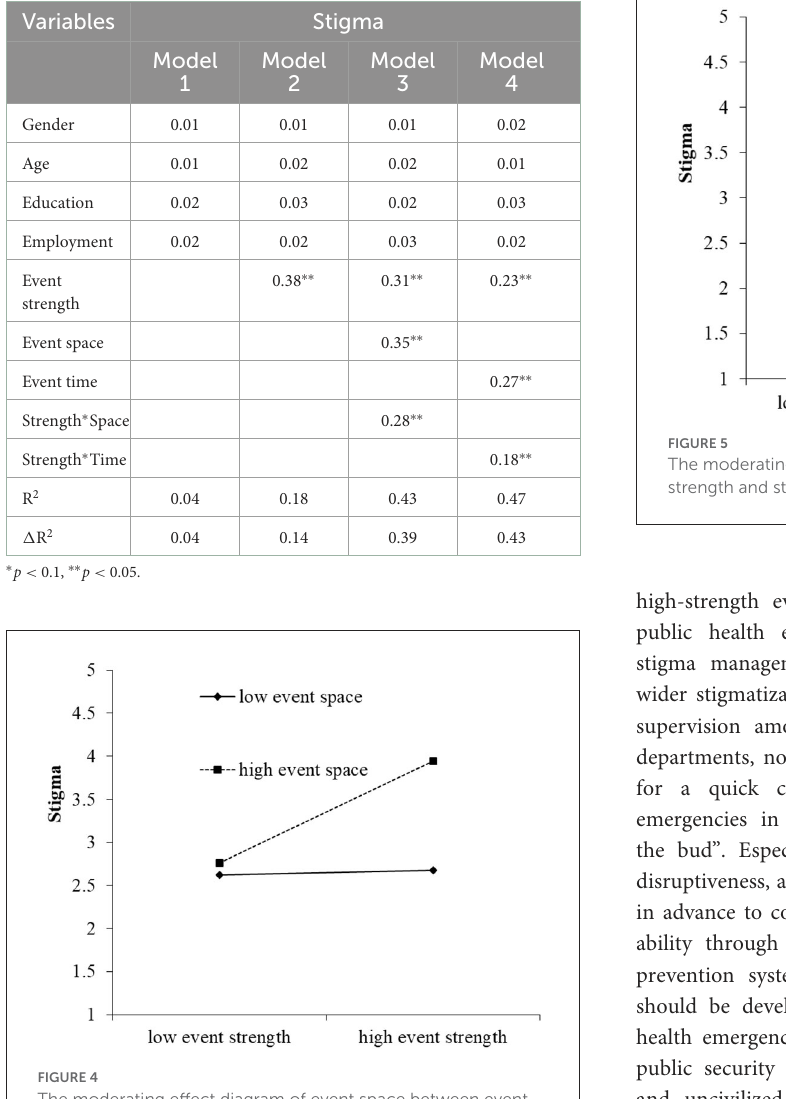
samples from 24 provinces in China. Finally, combined with EST and previous related research, we concluded EST-based stigma governance strategies.